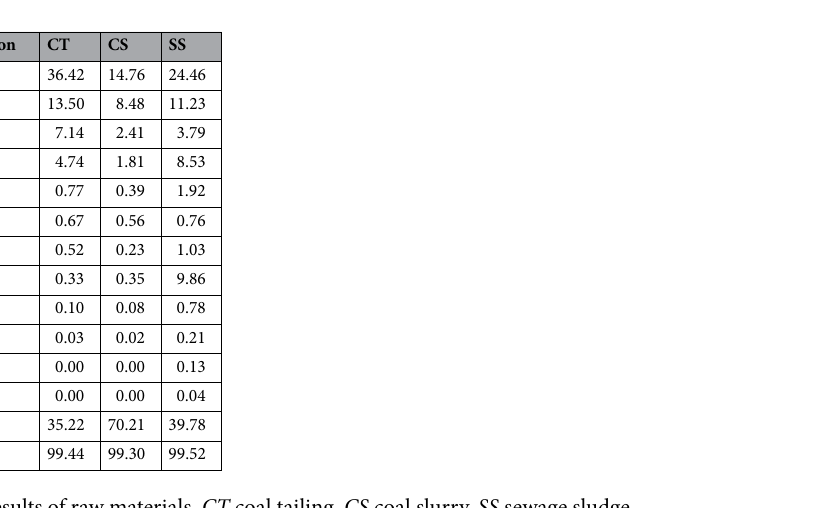
Table 2. XRF results of raw materials. CT coal tailing, CS coal slurry, SS sewage